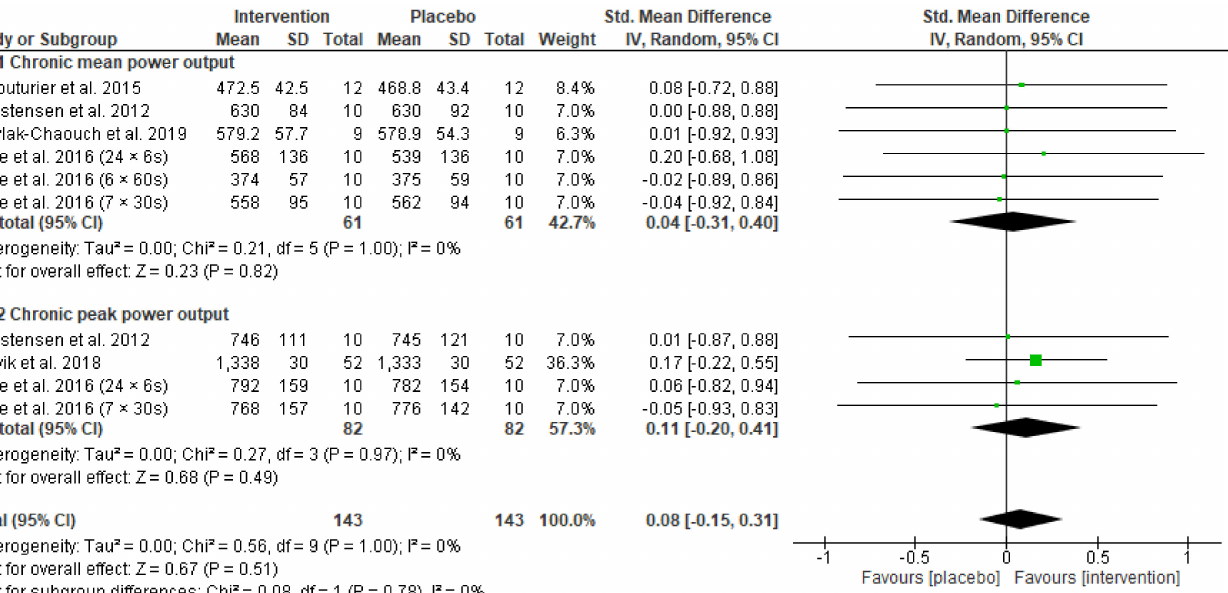
Figure 4. Forest plot comparing the effect of acute and chronic beetroot supplementation on peak power output.